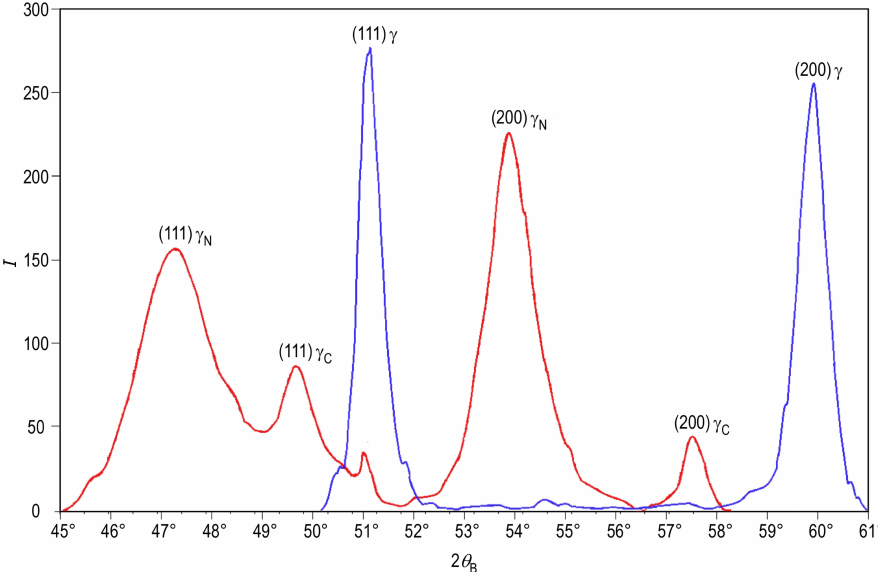
Figure 6. X-ray diffractograms of nitrocarburized (red graph) and non-treated (blue graph) AISI-316L ferrules, recorded with Co-K α radiation in Bragg–Brentano setting. I : Relative intensity, θ B : Bragg